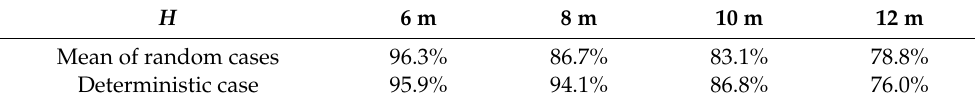
Figure 17. Variation of the maximum uplift displacement with the embedment depth of the tunnel for the stochastic and deterministic analysis: ( a ) Mean of random cases; ( b ) deterministic case. Table 3. Comparison of maximum vertical displacement between surface and